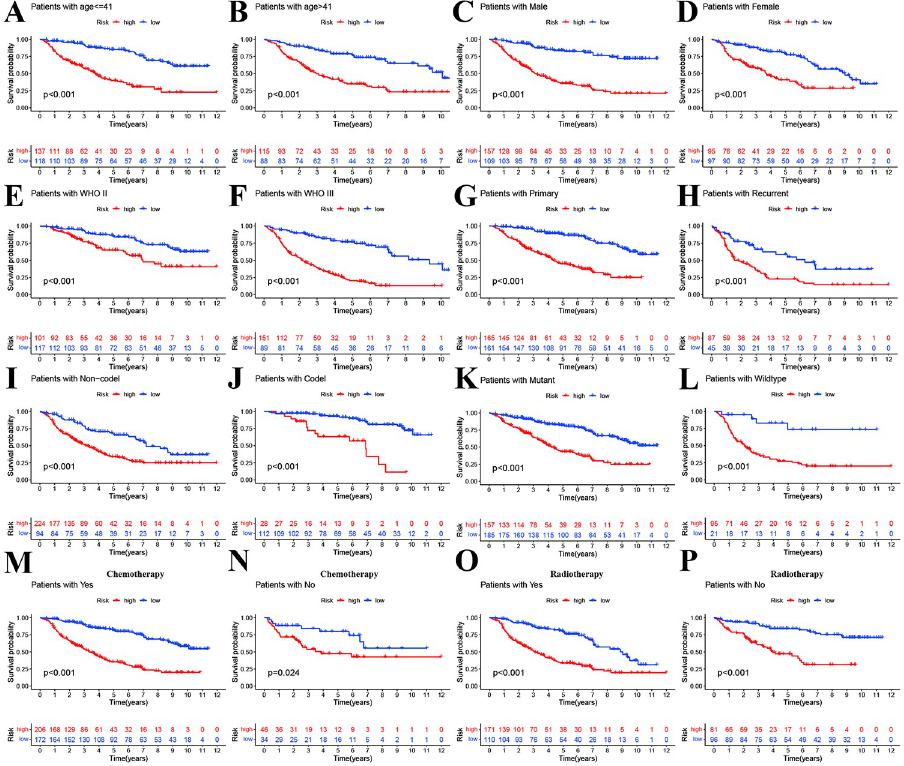
Fig 3. Stratified analyses for prognosis of high-and low-risk groups. A and B: age < = 41 vs age > 41. C and D: Male vs Female. E and F: WHO II vs III. G and H: primary vs recurrent. I and J: 1p19q non-codeletion and codeletion. K and L: IDH mutant vs wildtype. M and N: chemotherapy Yes vs No. O and P: Radiotherapy Yes vs